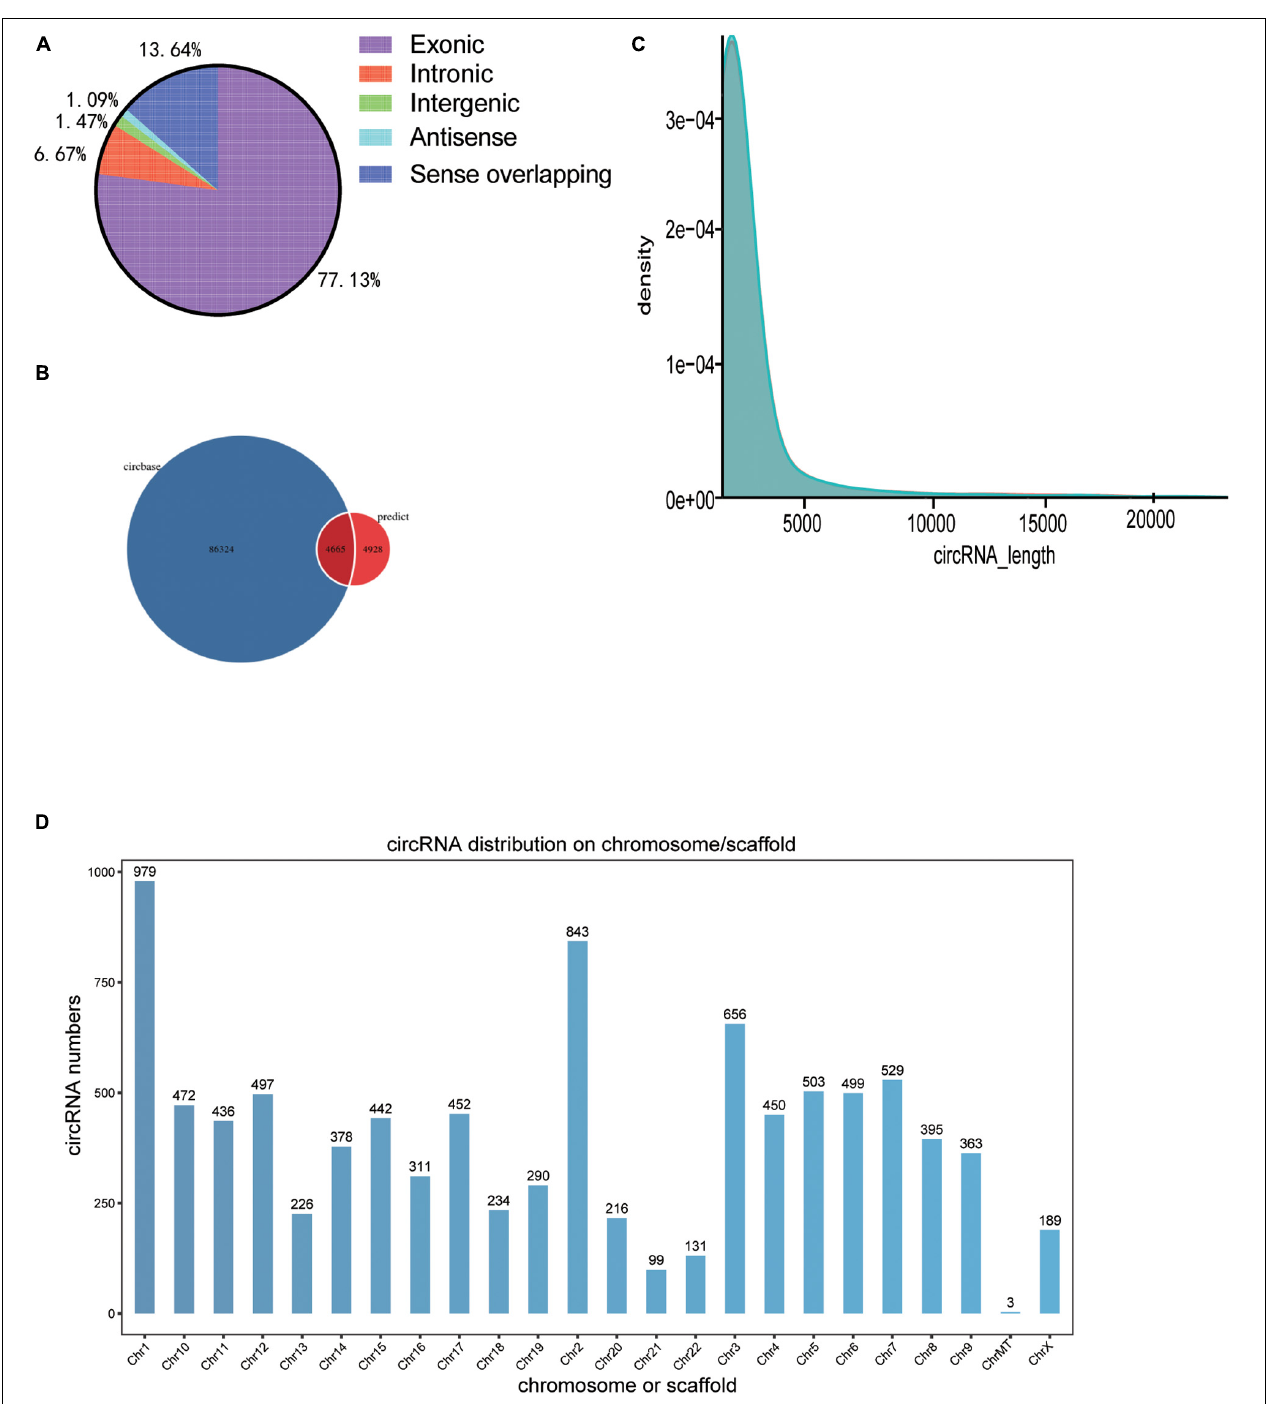
FIGURE 1 | Distribution spectrum of circRNAs. (A) Map of the circRNA class distribution, (B) Classification of circRNA based on the circBase database. (C) Length density map of circRNAs. (D) The histogram represents the total cirRNAs distribution of the test sample, and the ordinate represents the number of transcriptional parent genes of the number of cirRNAs on each chromosome Chr,